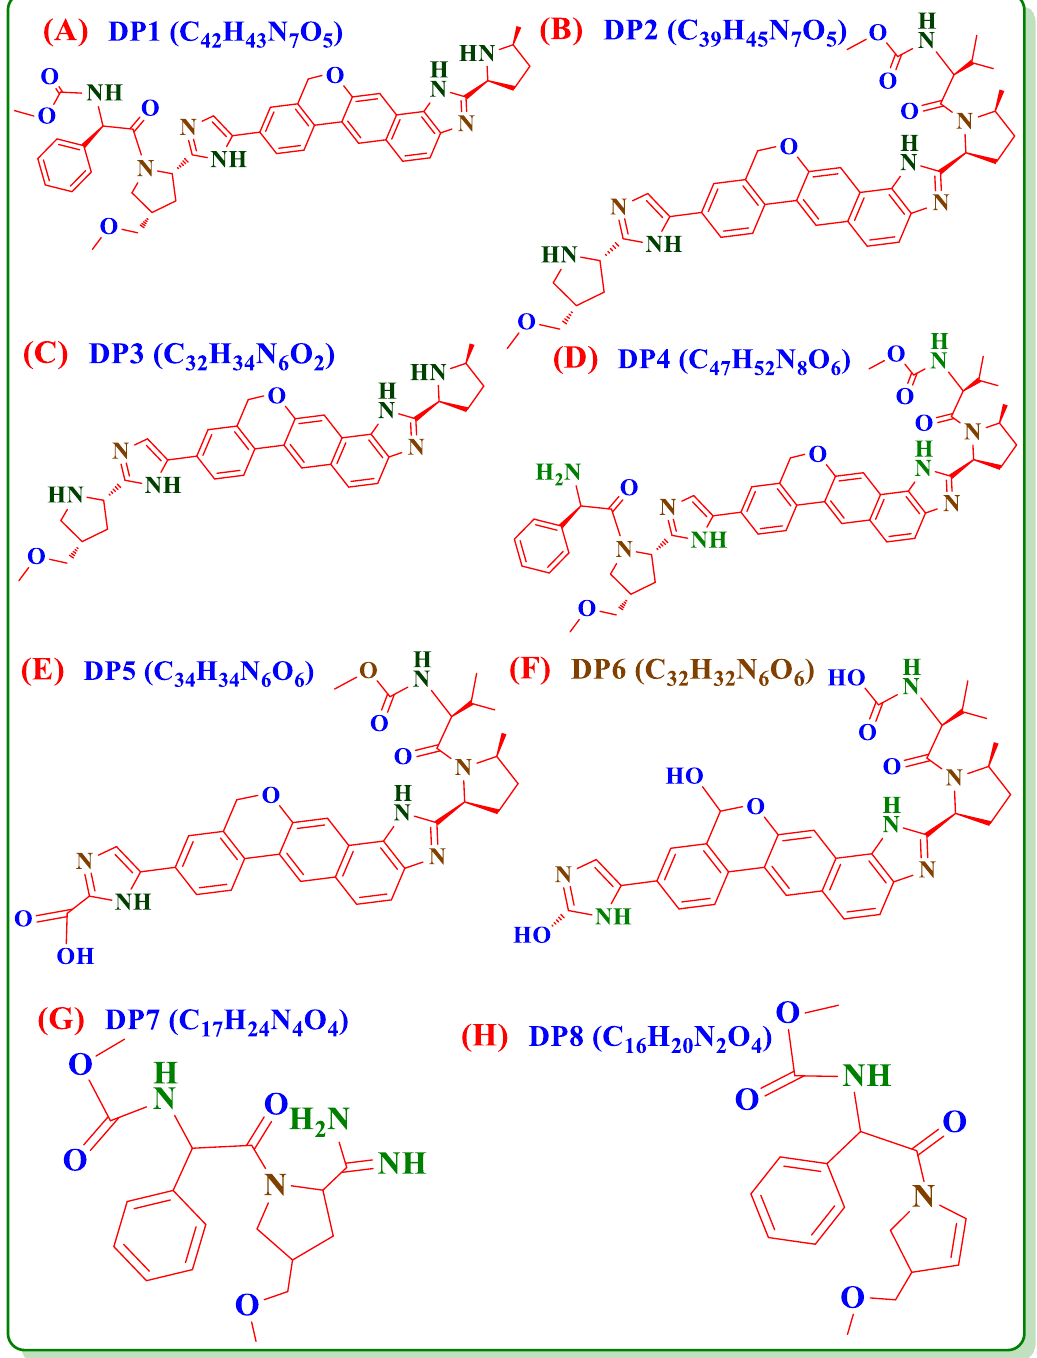
Figure 2. Chemical structures of degradation products of VEL ( A ) DP1, ( B ) DP2, ( C ) DP3, ( D ) DP4, ( E ) DP5, ( F ) DP6, ( G ) DP7 and ( H ) DP8.